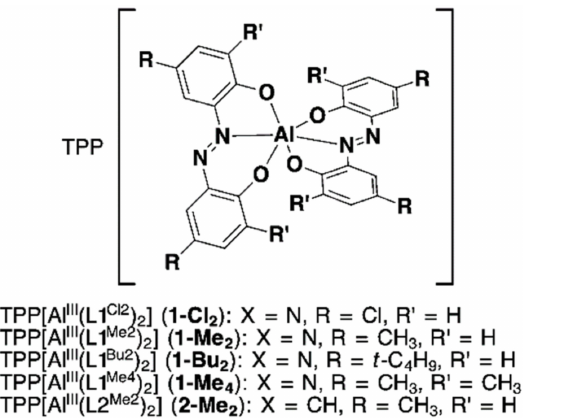
Figure 1. The molecular formula of the Al III complexes 1 and 2 (TPP = tetraphenylphosphonium